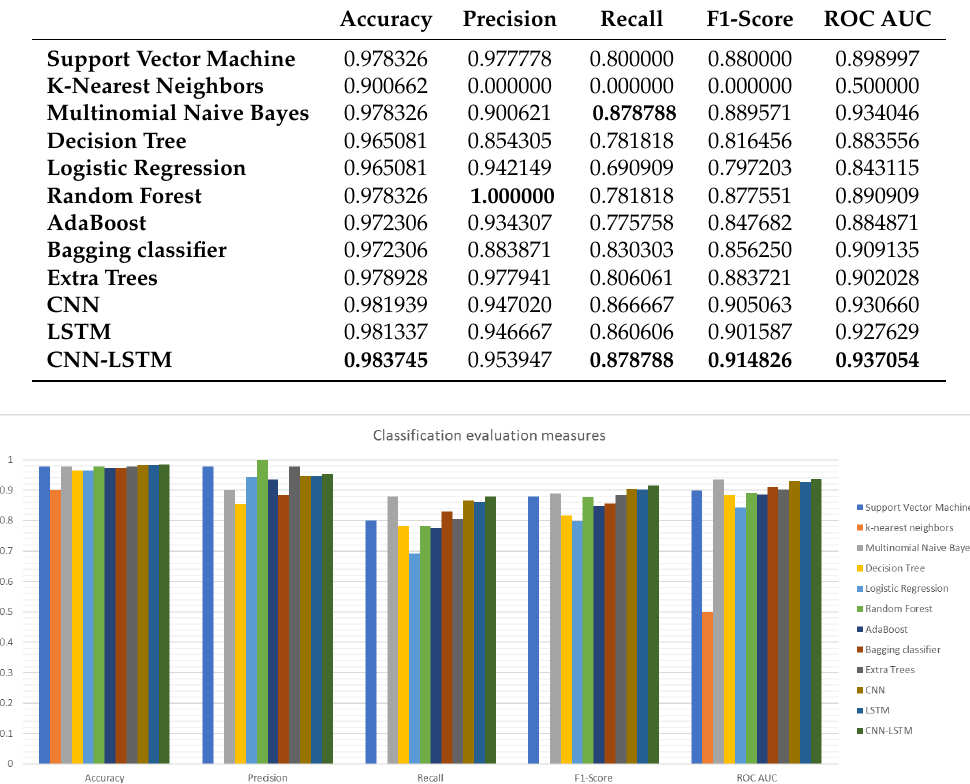
Table 3. Results of the classification algorithms.